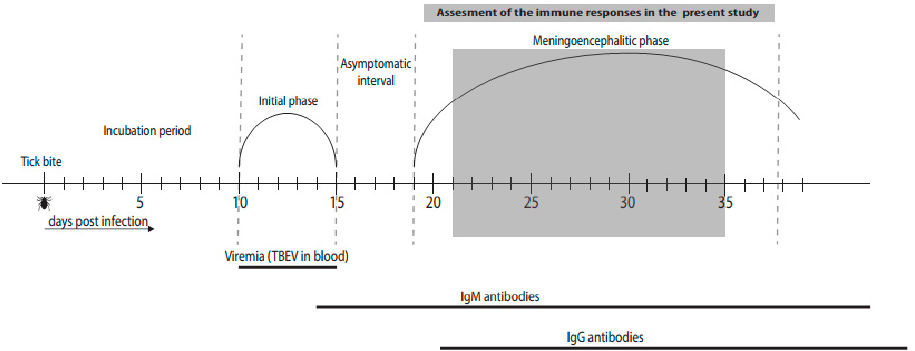
Figure 1. Schematic Diagram of the Course of Tick-borne Encephalitis. TBEV, tick-borne encephalitis